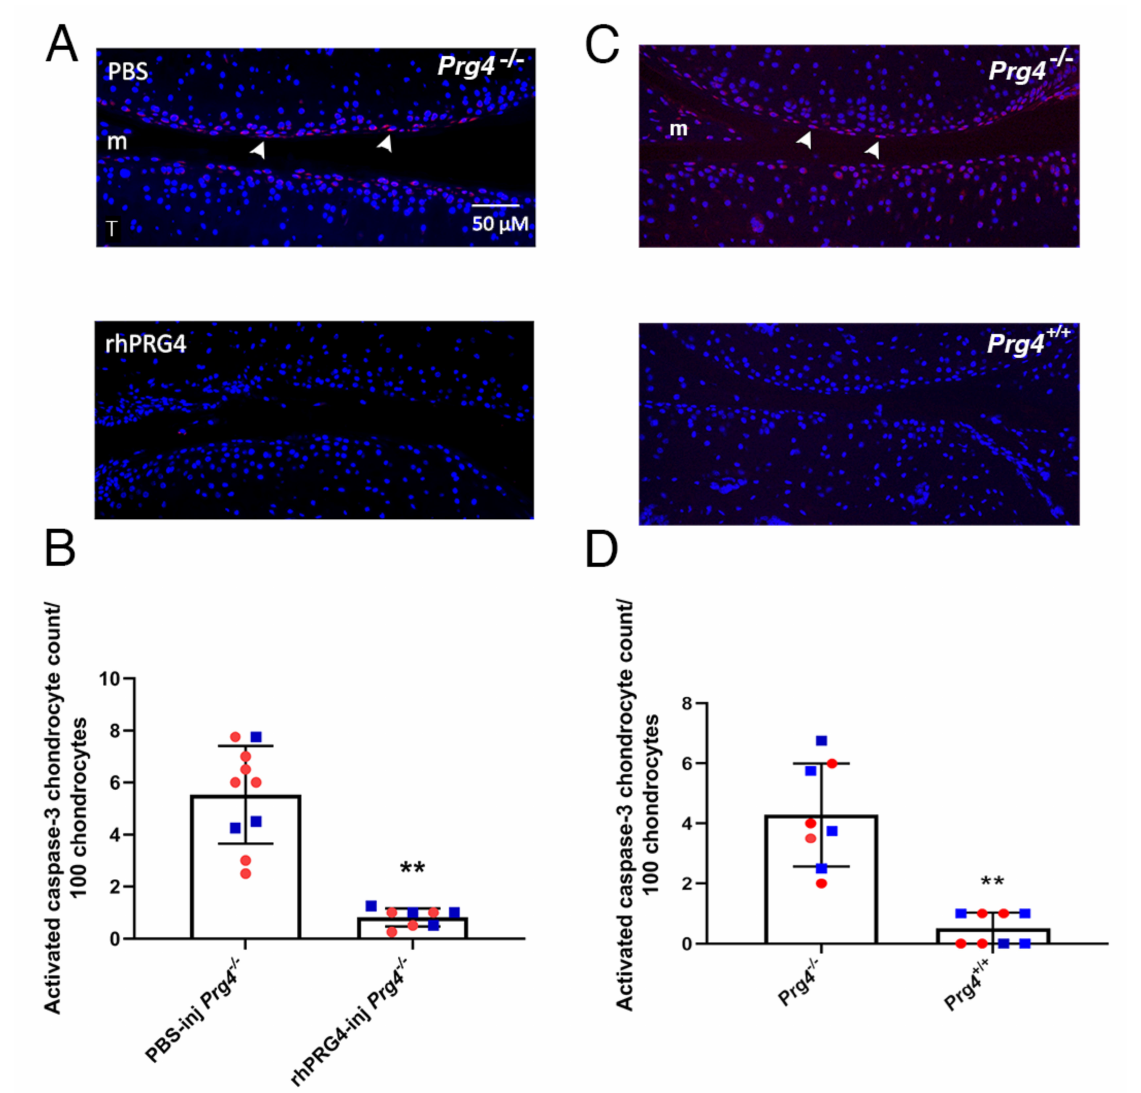
Figure 1. Suppression of caspase-3 activation by rhPRG4 in Prg4 − / − mouse joints. ( A ) Immunos- taining for active caspase-3 in representative knee joint coronal sections of 8-week-old Prg4 − / − mice that received IA rhPRG4 or PBS 10 days prior. Note the immunopositivity in superficial zone chondrocytes (arrow heads) that received PBS contrasted with littermates that received rhPRG4 and showed a smaller signal. The application of rhPRG4 in Prg4 − / − joints serves to reduce mechan- ical shear stress in both diseased and healthy cartilage. F = femoral condyle and m = meniscus. ( B ) Counts of chondrocytes with caspase-3 activation per 100 chondrocytes from both the femoral and tibial cartilage computed across 10 mice (3 (cid:4) ) treated with rhPRG4 10 days after IA injection. ( C ) Immunostaining for active caspase-3 in chondrocytes (arrow heads) in representative knee joint coronal sections of 8-week-old non-injected control Prg4 − / − and Prg4 +/+ mice. ( D ) Corresponding counts of chondrocytes with caspase-3 activa- tion in 8-week-old non-injected control Prg4 − / − (4 Mean ± SD displayed. ** p <